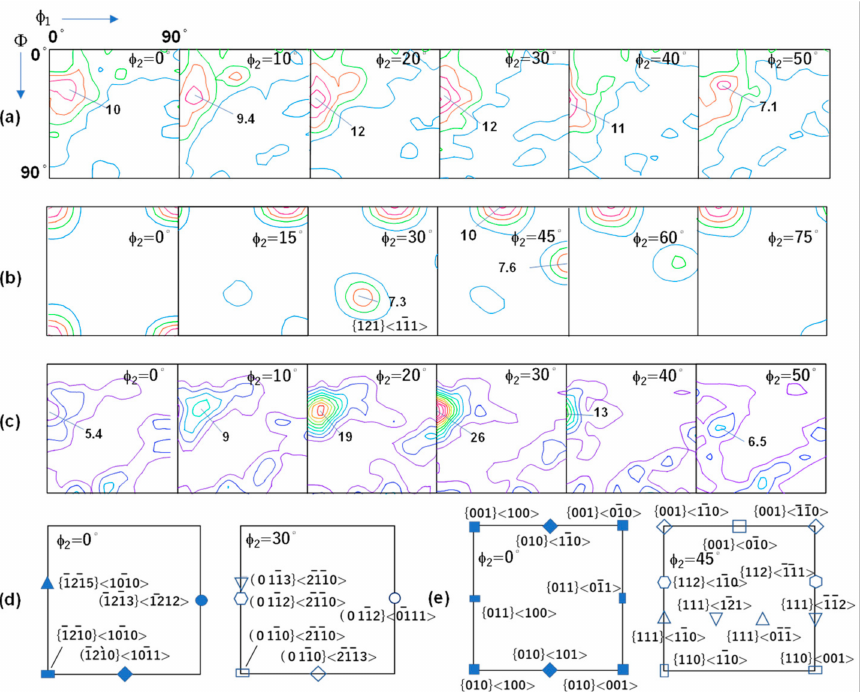
Figure 3. ODF sections of observed textures of CP-Ti, ( a ) initial α -hex at 800 ◦ C, ( b ) β at 950 ◦ C, ( c ) α - hex after transformation cycle at 400 ◦ C, and ( d , e ) important orientations in α -hex and β , respectively. Contour levels are 2, 4, 6.